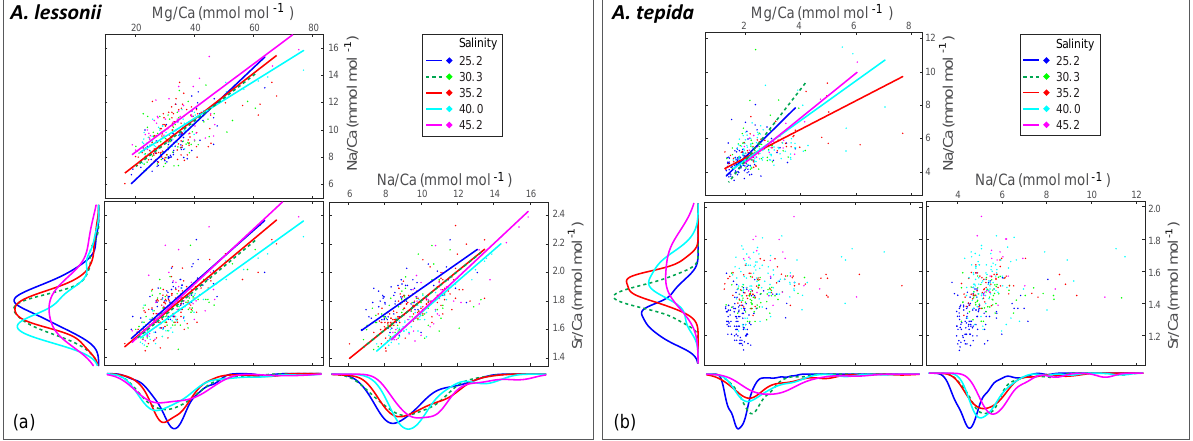
0 . 064 ± 0 . 013 × S + 3 . 29 ± 0 . 44, F 1 , 172 = 25 . 9, p < 0 .